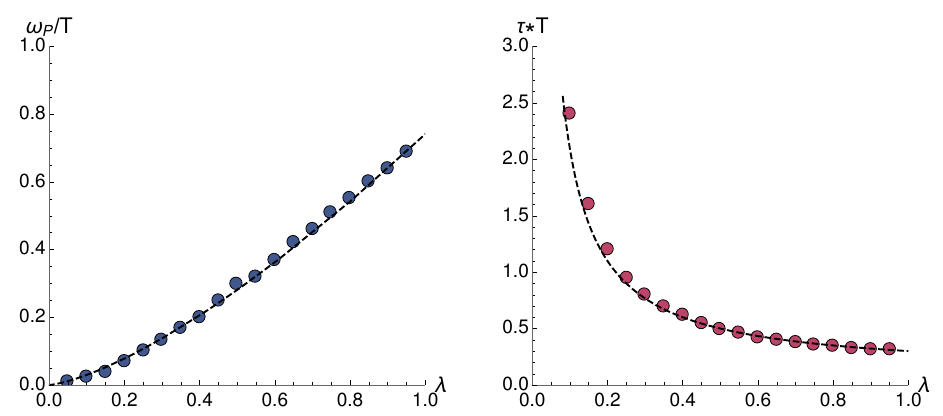
Figure 8 . Evolution of ! P and (cid:28) as functions of (cid:21) with (cid:12)xed (cid:22)=T = 1 obtained from (cid:12)tting the numerical data. The (cid:12)t for the relaxation time (cid:28) (dashed line) is consistent with a linearly inverse scaling (cid:28) (cid:24) (cid:21) (cid:0) 1 .